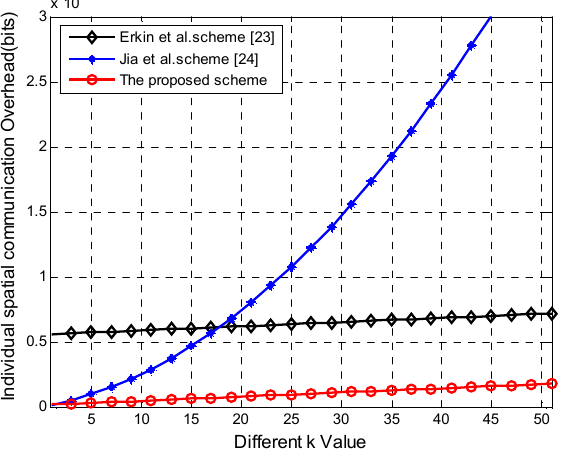
Figure 6. Variety of spatial communication overhead per node with the value k.